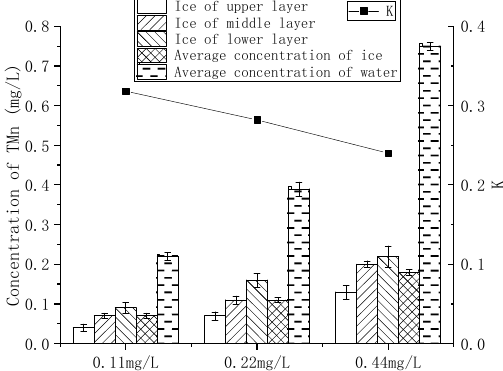
Figure 6. Distribution of TMn of Varying Initial Concentrations in the Ice-water System.